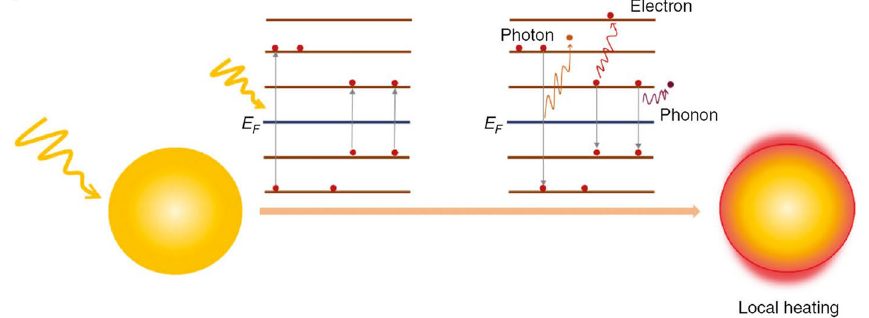
Fig. 7 PTT mechanism. Plasmon decay (electron-to-photon, electron-to-electron, and electron-to-phonon) generates local heating. Reprinted under a Creative Common Licence CC-BY 4.0. Copyright 2020 from Ref.